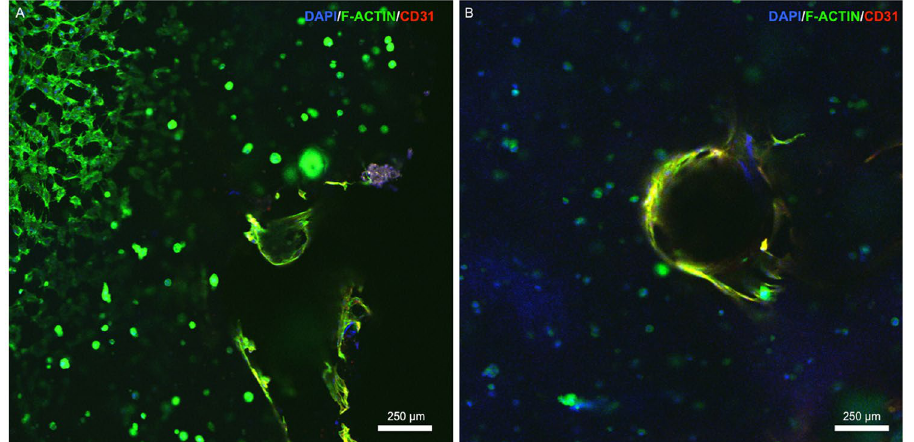
Figure 7. Confocal images of OD21 and ECFCs cultured in GelMA hydrogels in the full-length dental pulp- like tissue constructs. ( A ) OD21 cells had visibly higher spreading near the dentin walls (upper left corner of